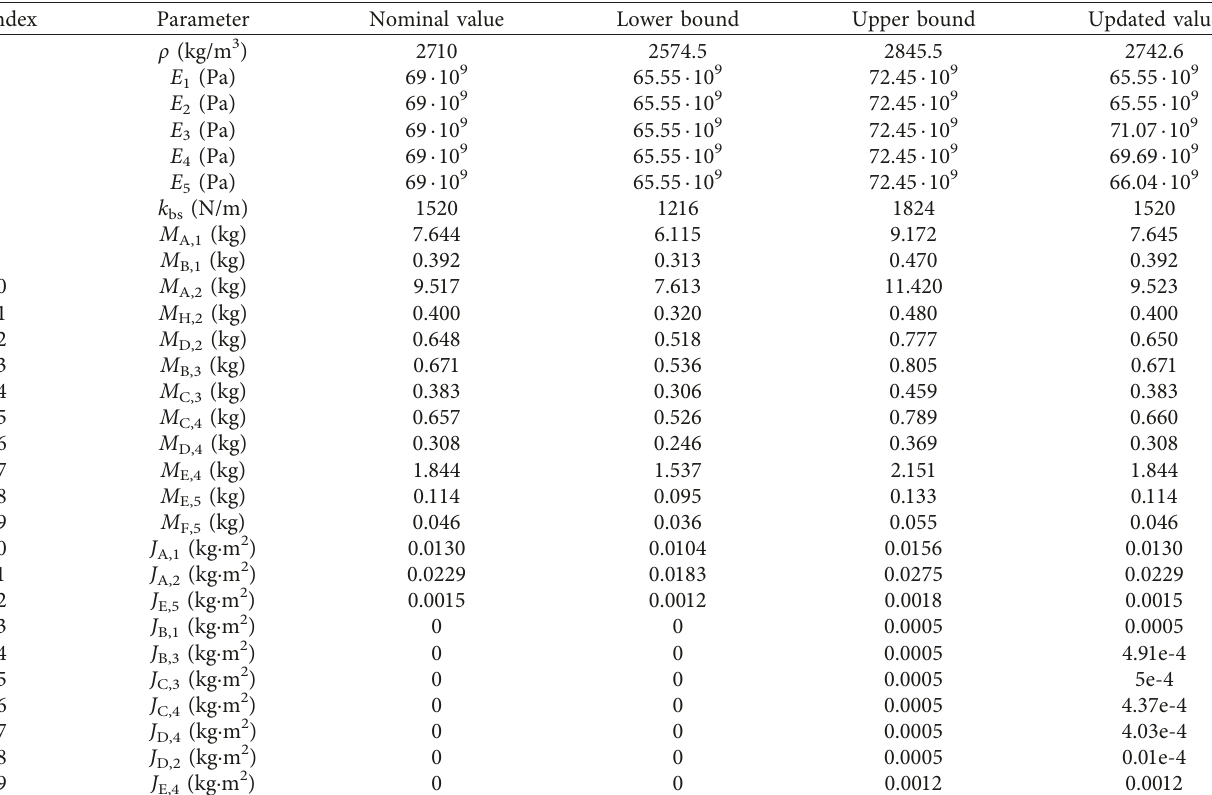
Figure 5: 7th row of the experimental frequency response matrix. Table 3: Updating